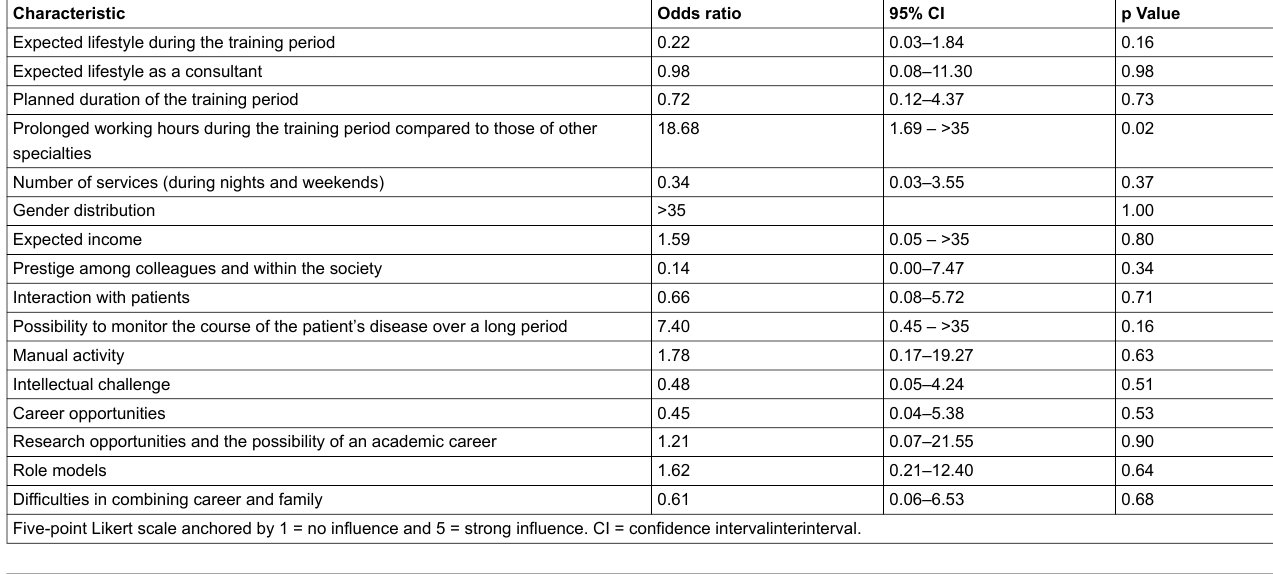
Table 3: Participants not indicating general surgery as a top three specialty choice at T1: Multivariate analysis of predictors (logistic regression) for not choosing a surgical career (n = 129, 17 missing). Characteristic